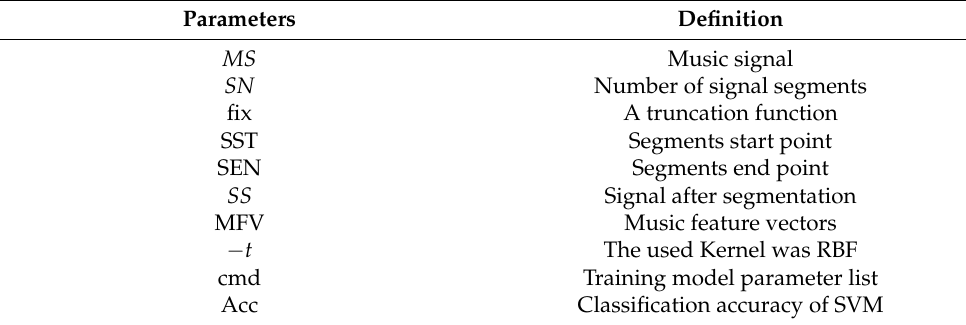
Table 5. Parameters in Algorithm